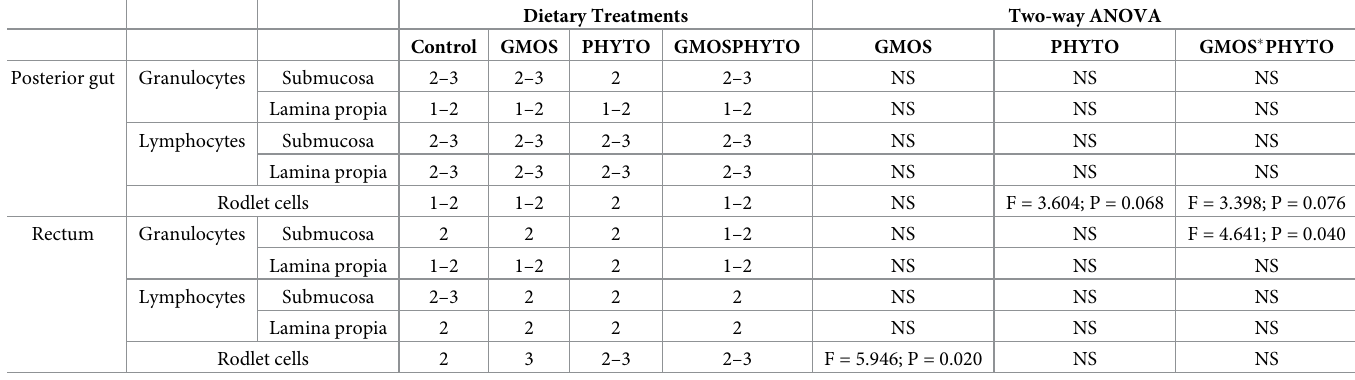
Table 7. Scoring of submucosa-and lamina propria- infiltrated leukocytes subpopulations in posterior gut (preileorectal valve) and rectum (postileorectal valve) for European sea bass ( Dicentrarchus labrax ) at the end of the feeding trial (t = 63 days). Dietary Treatments